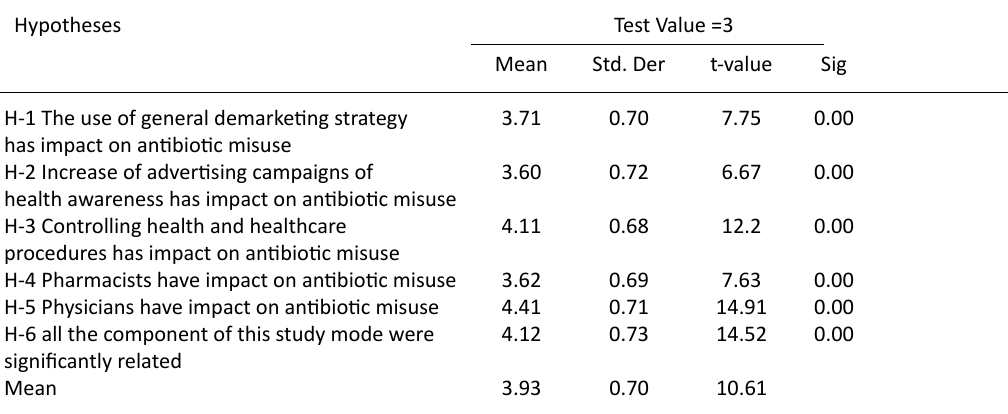
Table 2. Testing hypotheses Hypotheses